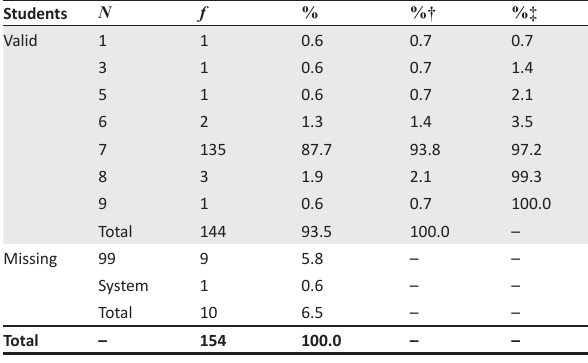
TABLE 5: Students’ performance on rapid HIV